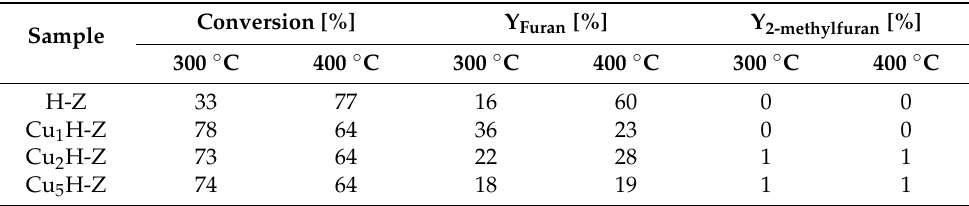
Table 3. The influence of Cu content and temperature on catalytic properties of Brønsted acid sites-containing samples.